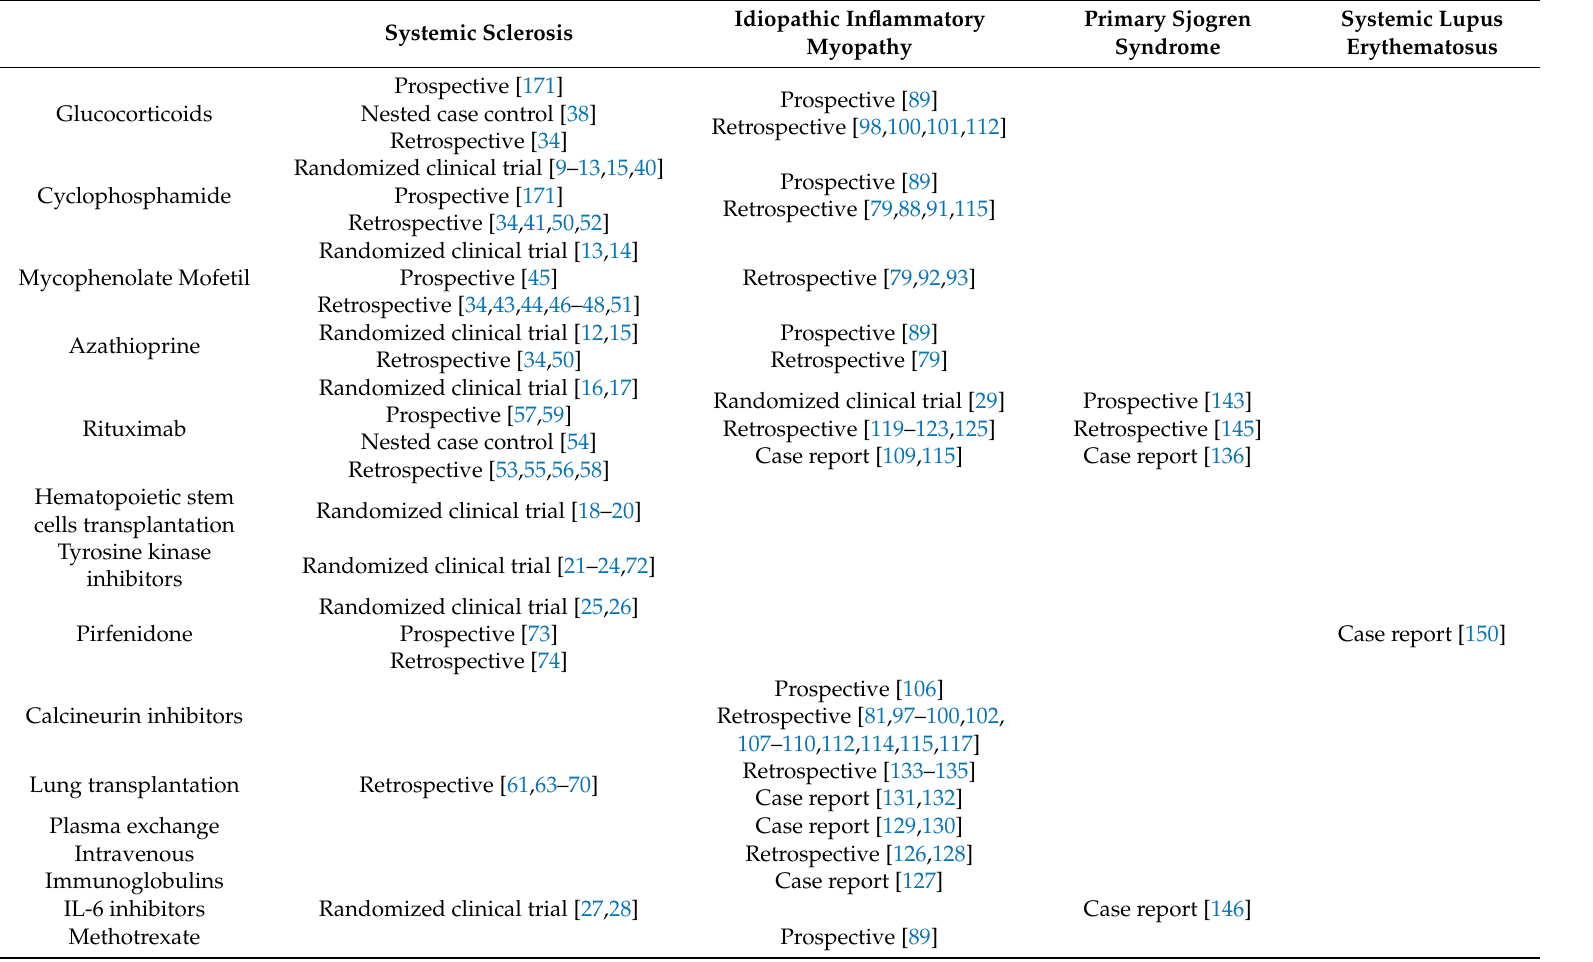
Table 2. Treatment of patients with CTD related ILD. Summary of the literature according to the study